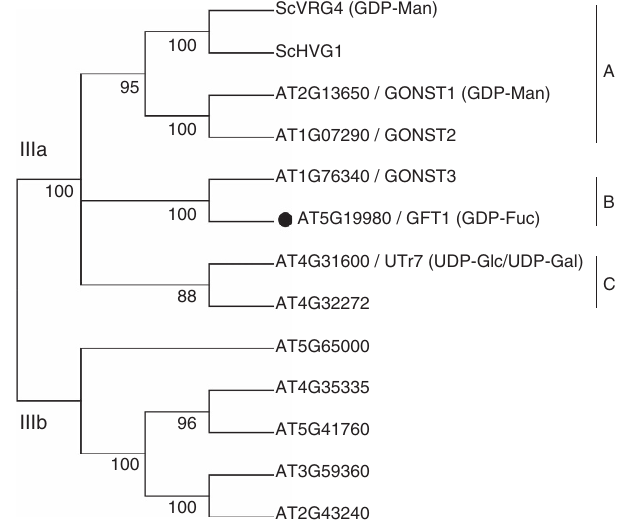
Figure 1 | Phylogenetic tree of the Arabidopsis NST sub-family III. Full-length amino-acid sequences were aligned and the phylogenetic tree generated using MEGA6. Clades were assigned as previously reported 20 . The yeast GDP-Man transporter ScVRG4 and its paralogue ScHVG1 have also been included in the phylogenetic analysis. The sub-clade IIIa contains the previously characterized Arabidopsis GDP-Man transporter GONST1 (ref. 23) and UDP-Glc/UDP-Gal transporter UTr7 (ref. 27). Only bootstrap values 4 50% are